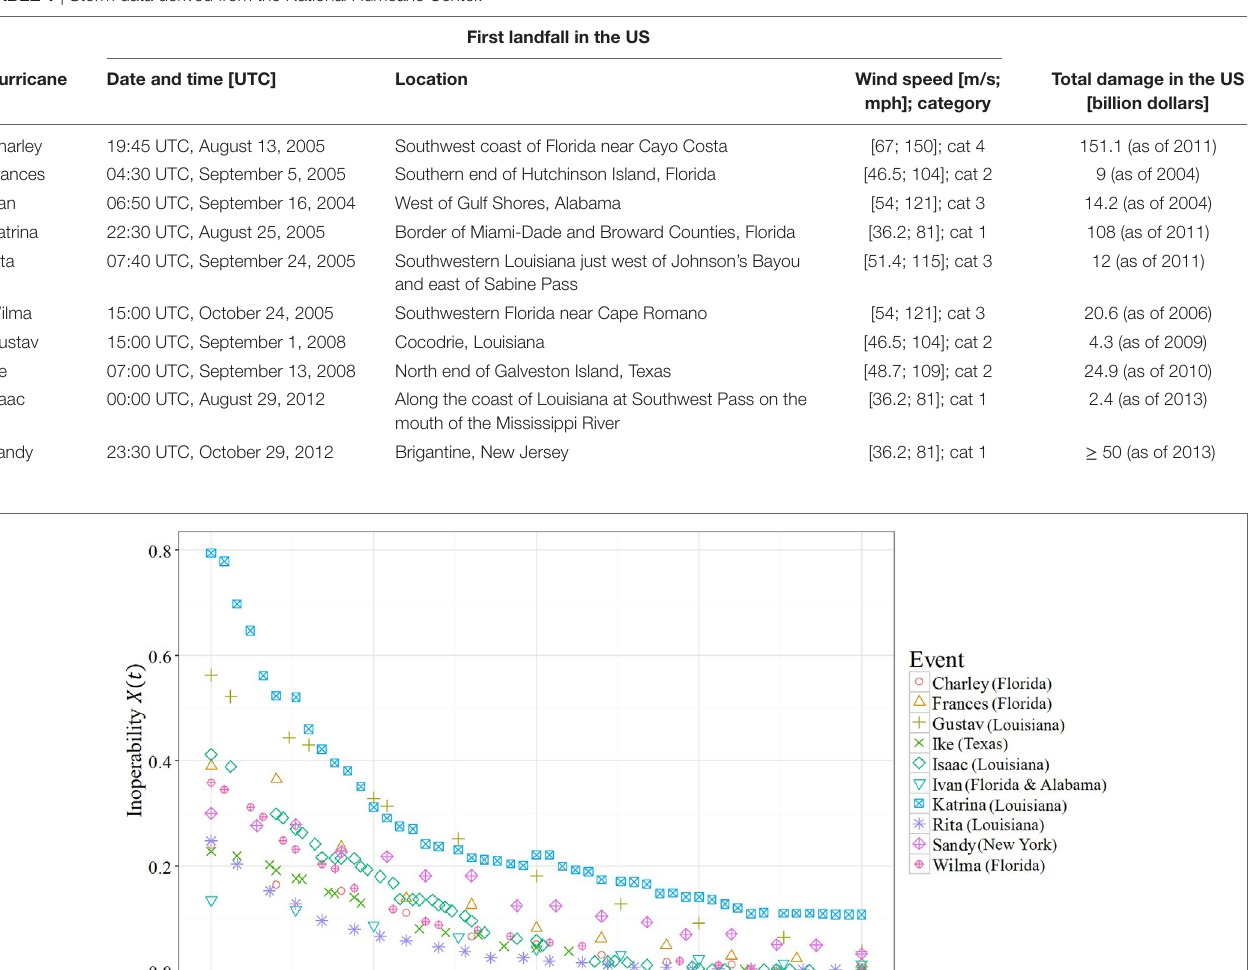
TaBle 1 | Storm data derived from the National Hurricane Center.